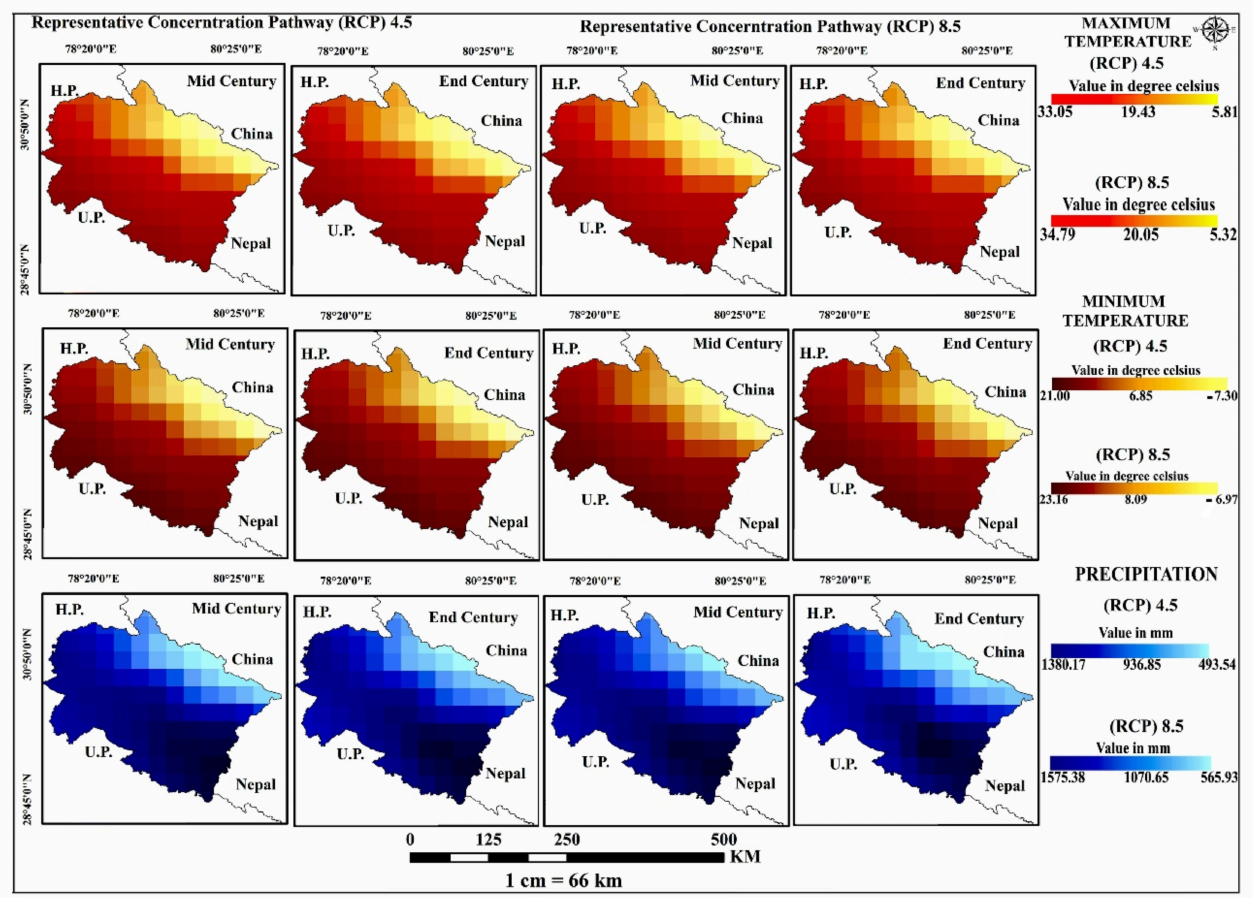
Figure 5. Projected spatial representation of annual average precipitation (based on model ensemble) and temperature (maximum & minimum) from MC to EC for the multimodel ensemble of RCM (RCP 4.5 and RCP